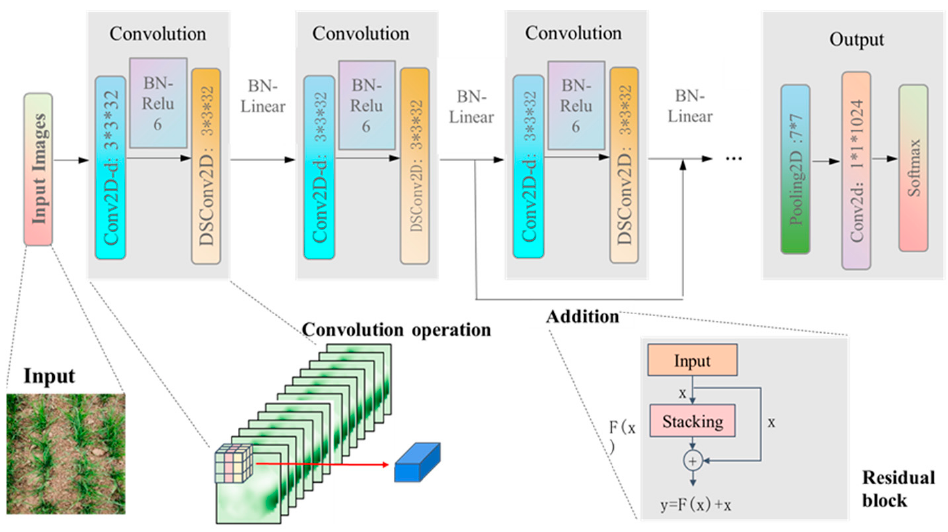
Figure 3. Structure of convolutional neural network. Table 2. Network parameters of the wheat growth stage detection model.